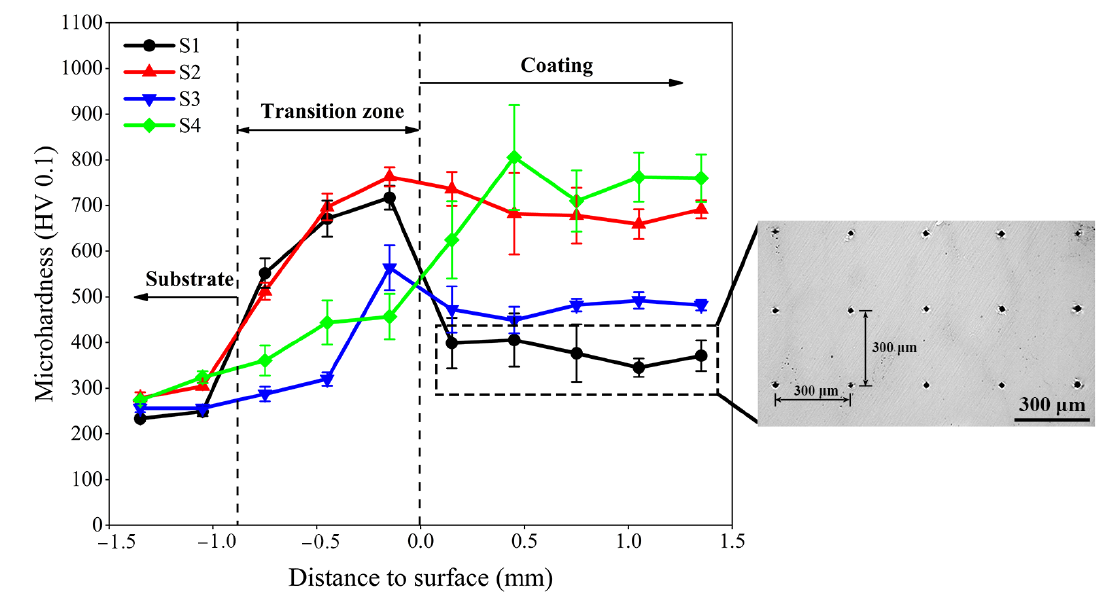
Figure 10. Microhardness distribution along the cross-sectional depth of the coating.